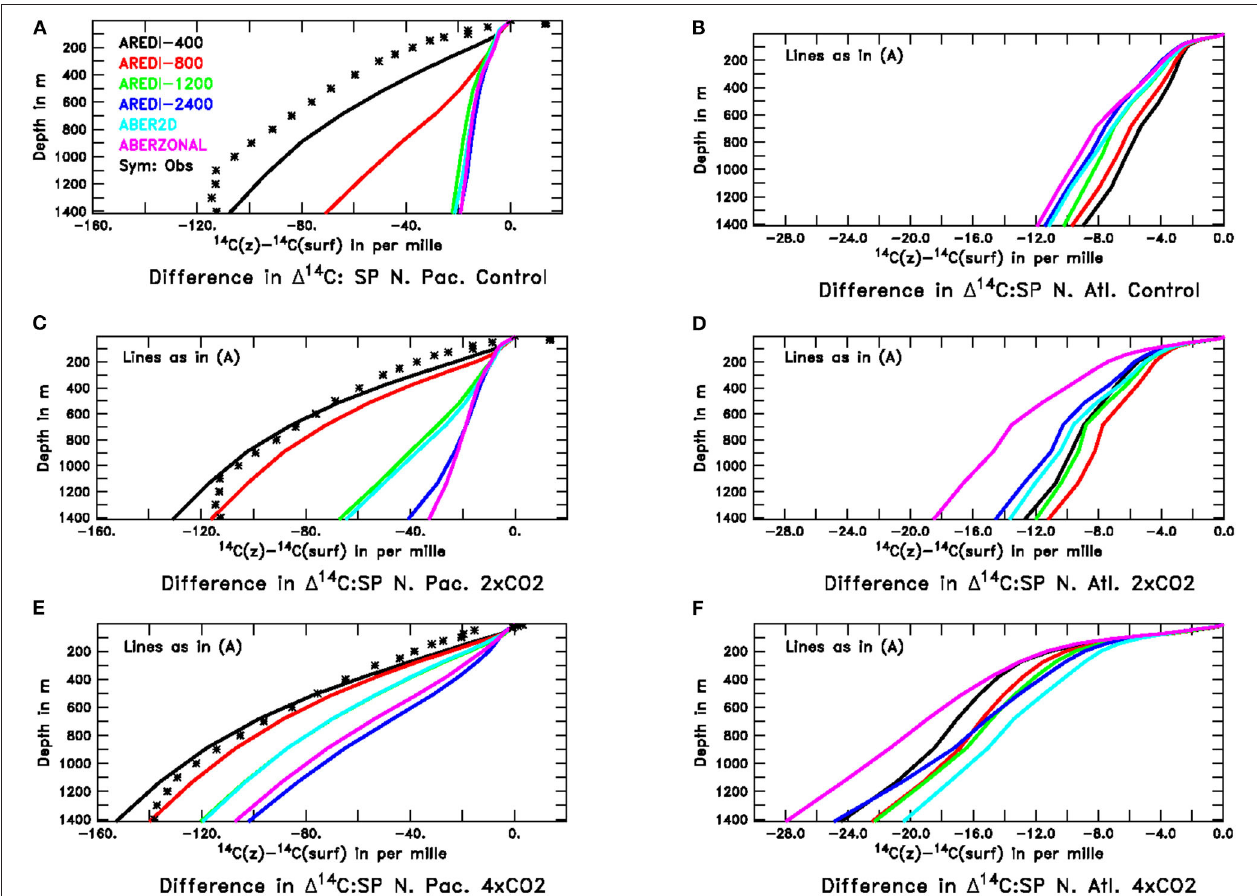
FIGURE 13 | Profiles of radiocarbon relative to its surface value in the subpolar North Pacific and North Atlantic across our model suite. Observational estimates of pre-bomb radiocarbon from Key et al. (2004) are shown for the North Pacific with the symbols. For the North Atlantic the methods used to remove the signal of atmospheric nuclear testing do not work as well, and the deep ocean ends up having a higher radiocarbon concentration than the surface-a physically nonsensical result. For this reason we do not show the Key et al. (2004) estimates for this region. Top row shows the pre-industrial control simulations, middle row the 2xCO 2 simulations and bottom row the 4xCO 2 simulations. All model results are from century-long averages. (A) North Pacific, Control (B) North Atlantic, Control (C) North Pacific,